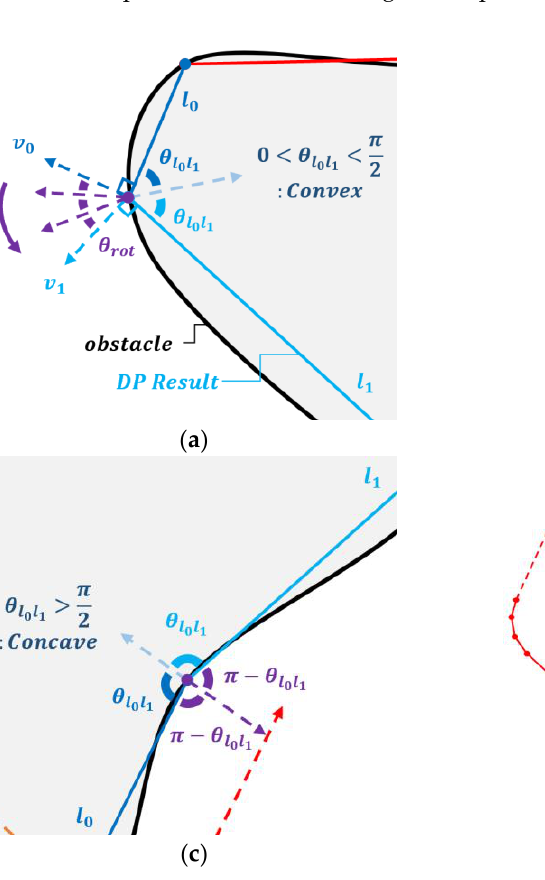
Figure 3. Abstract process of Expanded Douglas – Peucker (EDP) algorithm: ( a ) Before applying EDP for a convex corner; ( b ) After applying EDP for a convex corner; ( c ) Before applying EDP for a concave corner; ( d ) Overall appearance after applying EDP for a concave corner.